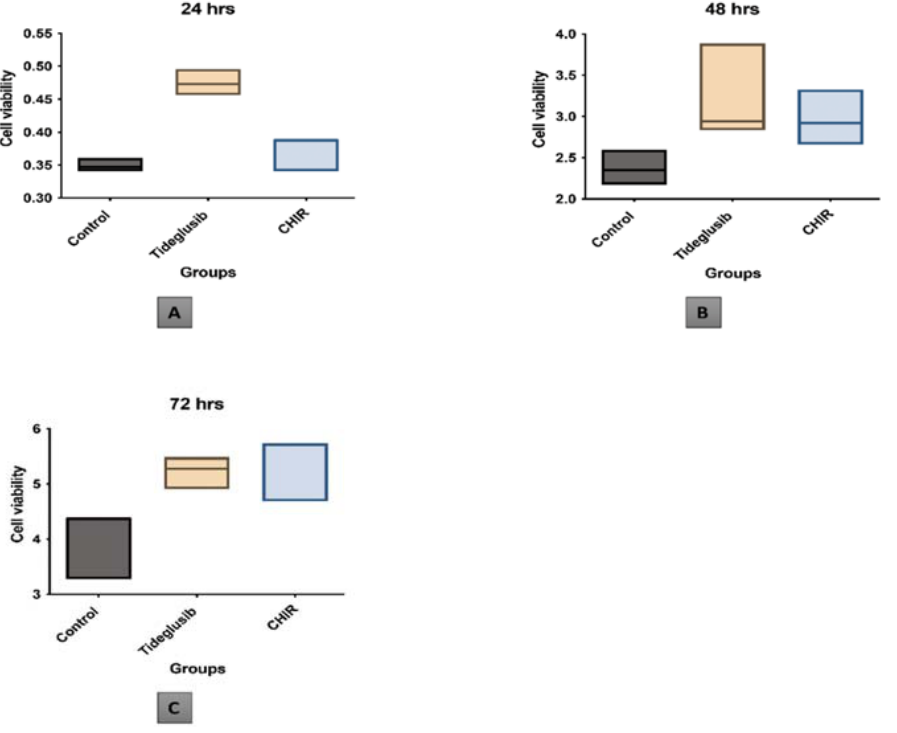
Figure 5. One ‐ way ANOVA graph presentation of the three groups vs. cell viability of: ( A ) At 24 h. ( B ) At 48 h. ( C ) At 72 h.